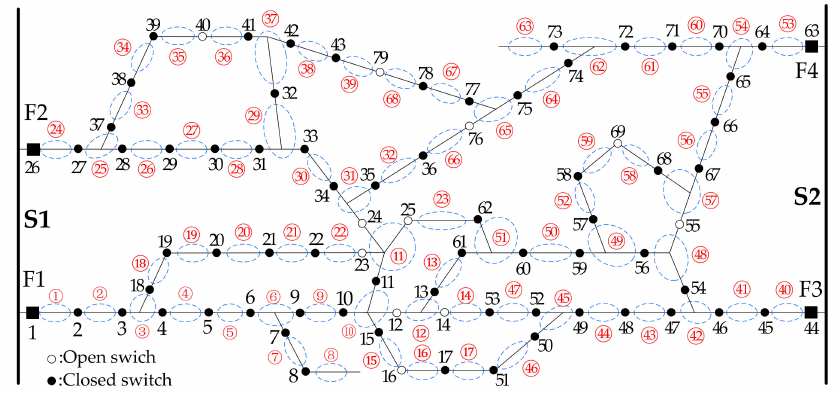
Figure 12. The test distribution